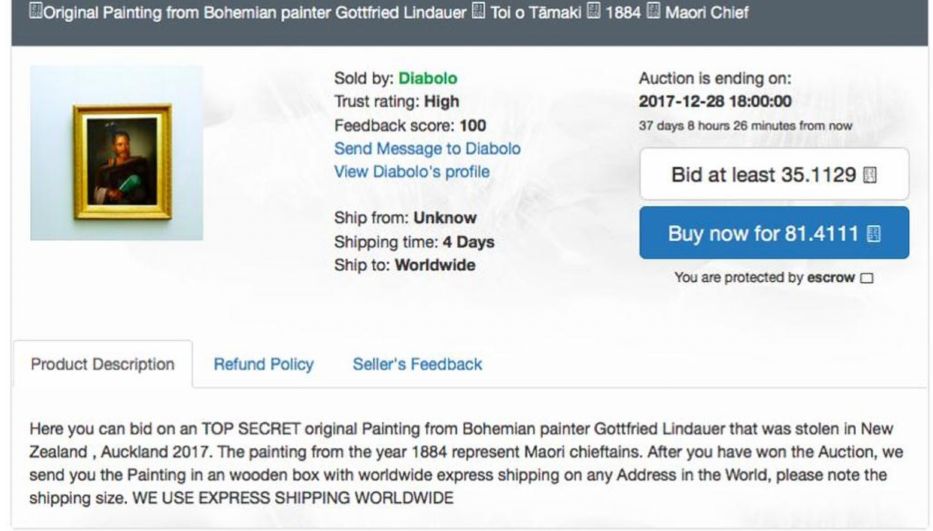
Figure 3. Screen grab of the listing for the stolen Chief Ngatai-Raure painting on the Dark Web auction site White Shadow, the painting was available to ship worldwide (Courtesy of Burgess/WIRED UK